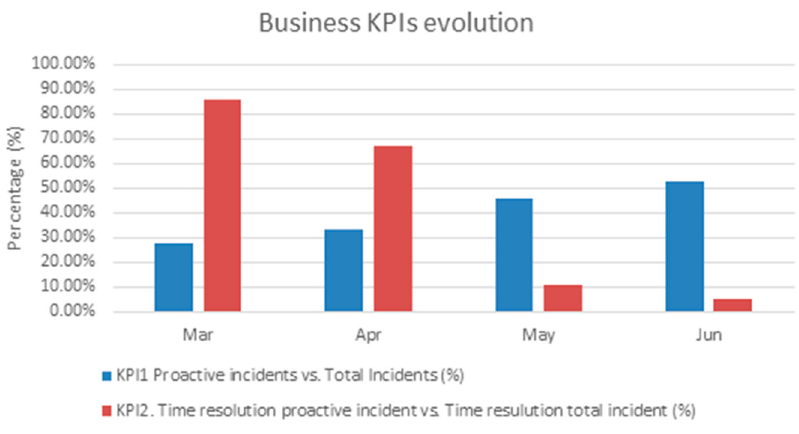
Figure 10. KPI monthly evolution.